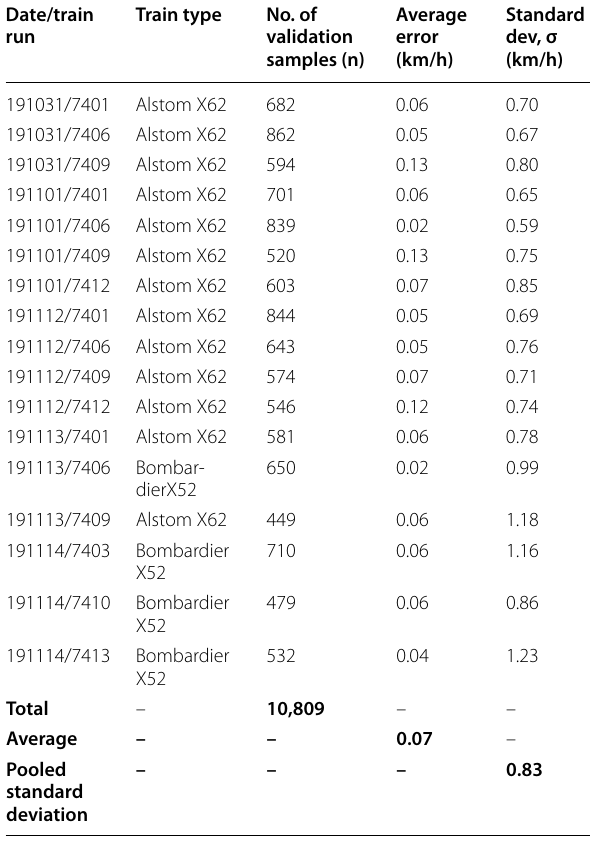
Table 5 Alternative 3: speed validation based on D_LRBG and trainborne clock in message TPR